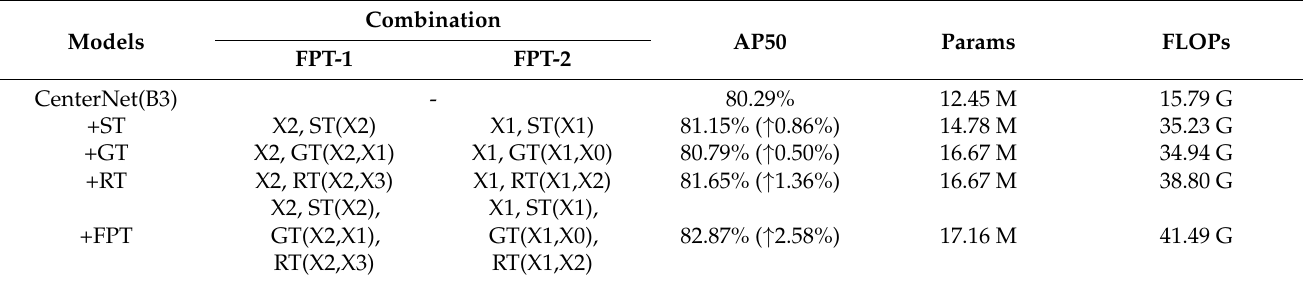
Table 4. Impact of FPT components on model performance.